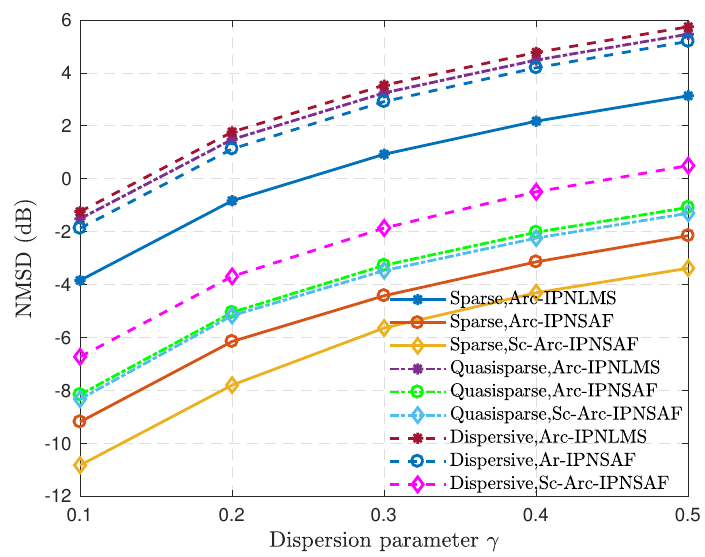
Figure 10. Steady-state NMSD with different λ for the BPSK